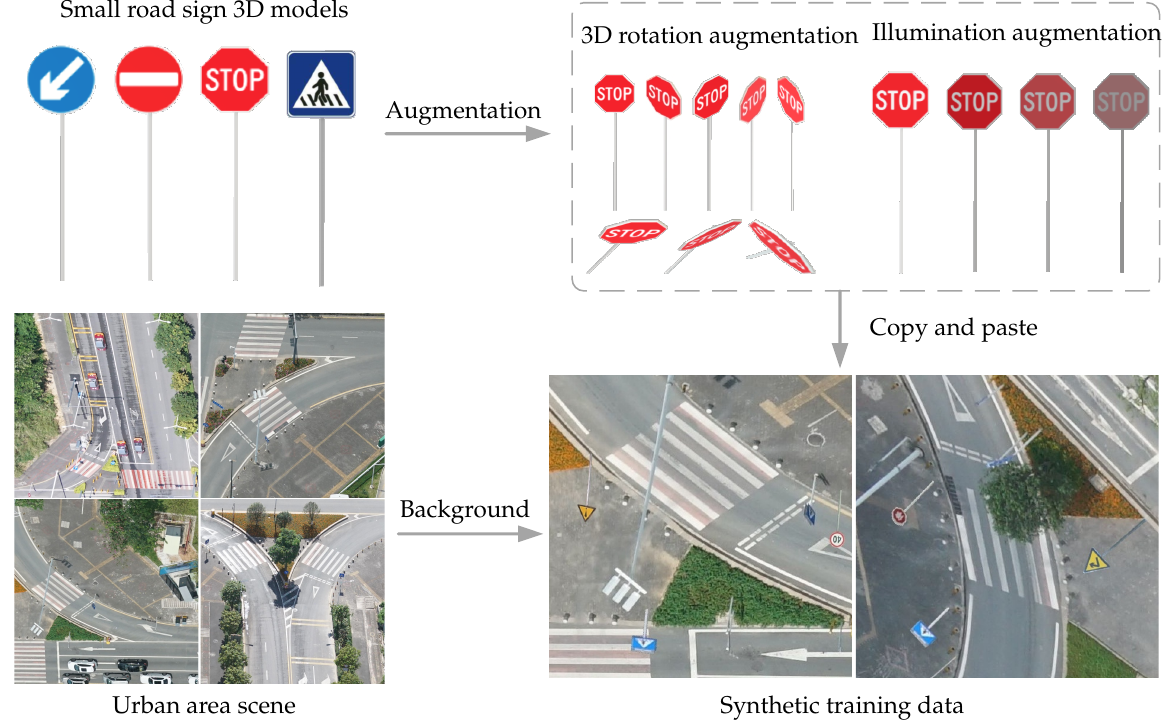
Figure 4. Schematic of data synthesis and augmentation with 3D rotation and lighting transformation using computer-aided design 3D road sign models.